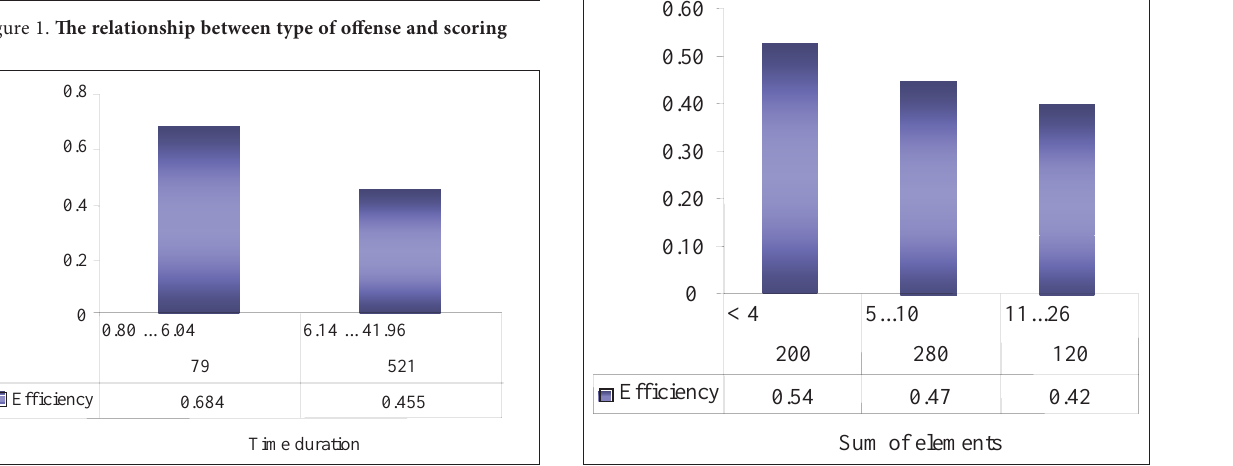
Figure 4. Th e relationship between sum of elements in the off ensive zone and